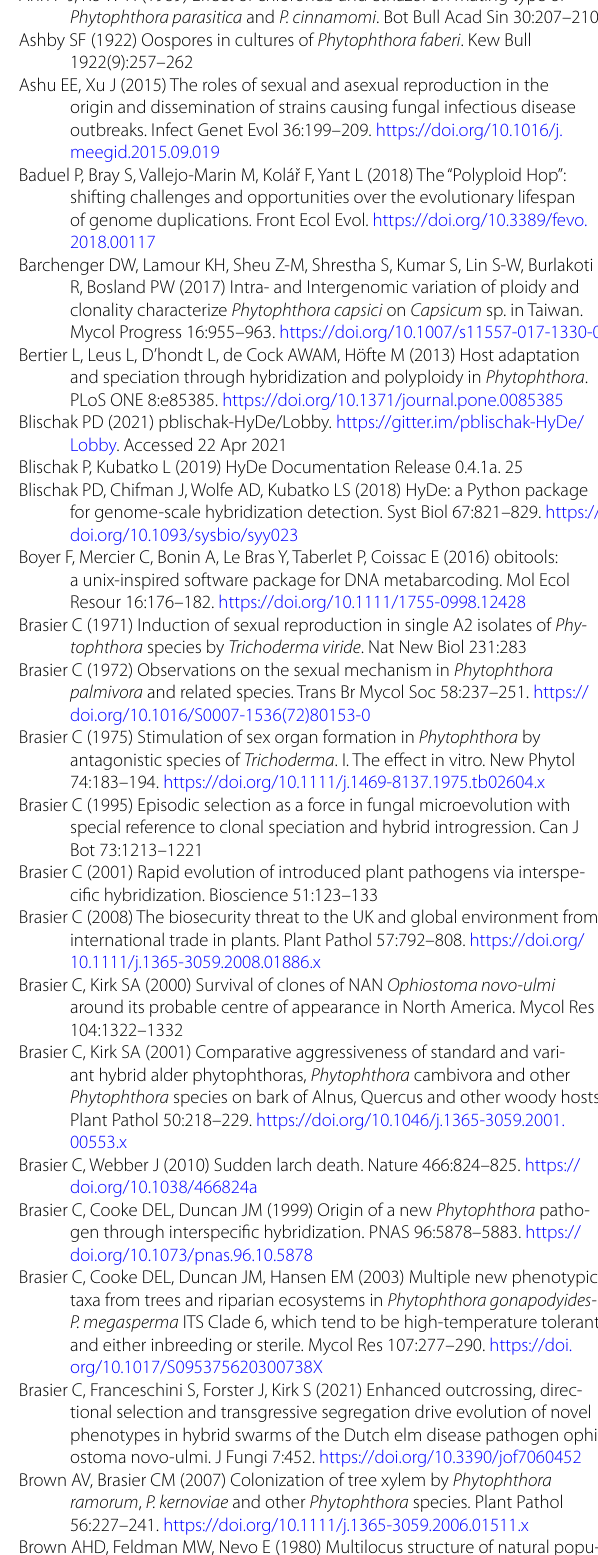
Additional file 10: Figure S8 . Distribution (histogram) of allele balance values for all Phytophthora cambivora isolates by DAPC groups. The × frequency of the most abundant heterozygous allele is displayed in light blue, the frequency of the second most abundant heterozygous allele is displayed in dark blue. Expectations of the allele balance are displayed on the